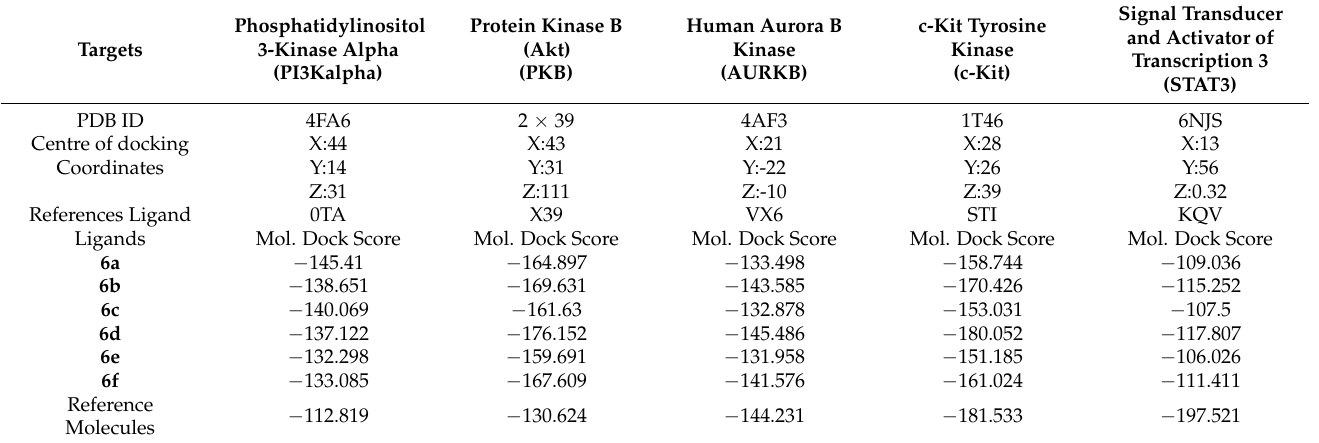
Table 3. Docking of compounds 6a–6f to five targets with codes, grid box coordinates and molecular docking